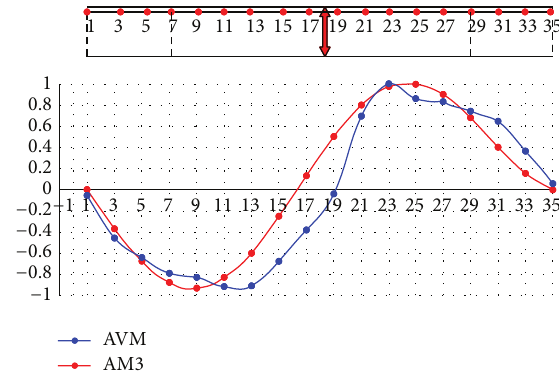
Figure 28: Experimentally and mathematically identified second transverse mode